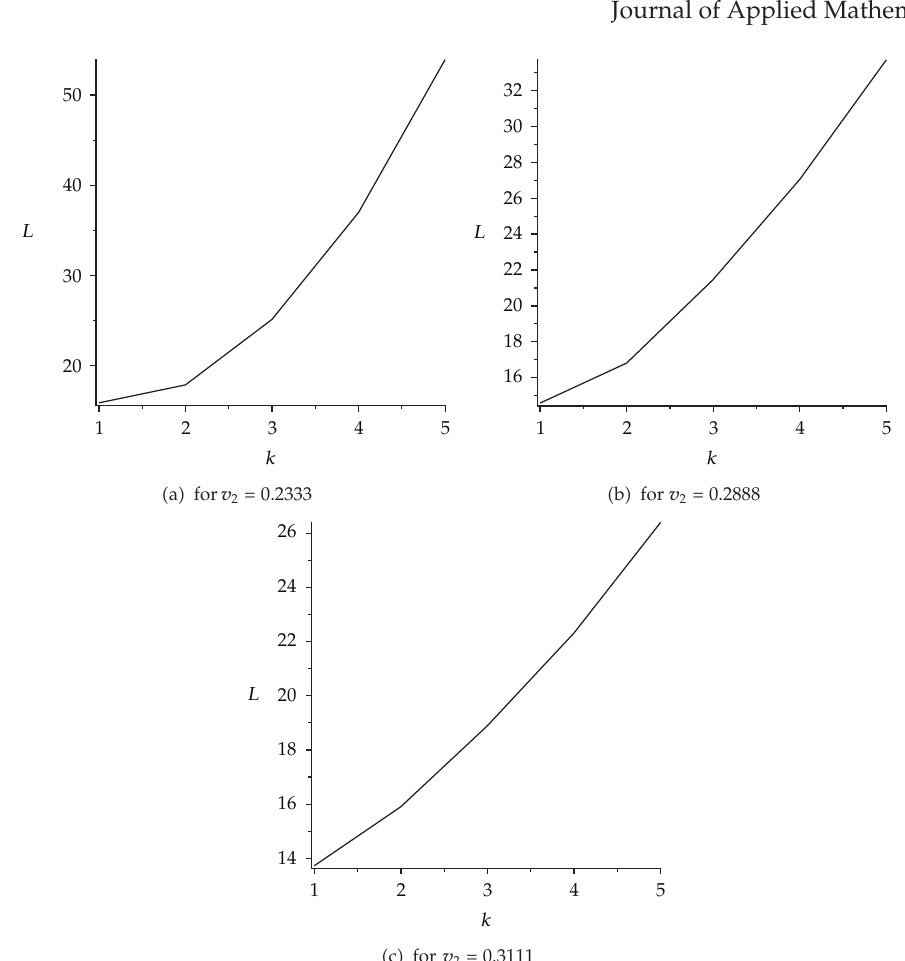
Figure 4: Presents comparison among total absolute curvature of 3-point ternary interpolating scheme for di ff erent values of parameter. Here L represents total absolute curvature and k represents number of iterations.